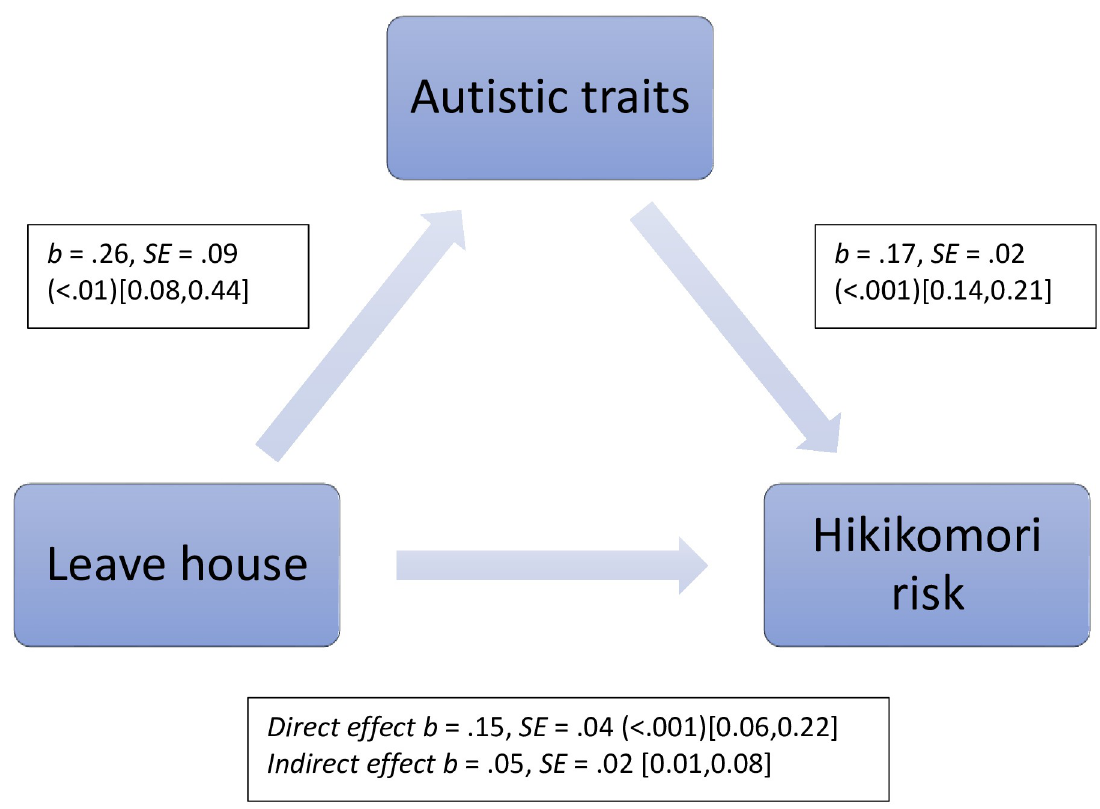
Fig 2. The indirect effect of autistic traits on the association between leaving the house and hikikomori risk. Regression coefficients are unstandardized. p values are shown in parentheses where applicable. 95% percentile bootstrap confidence intervals are shown in square brackets [5,000